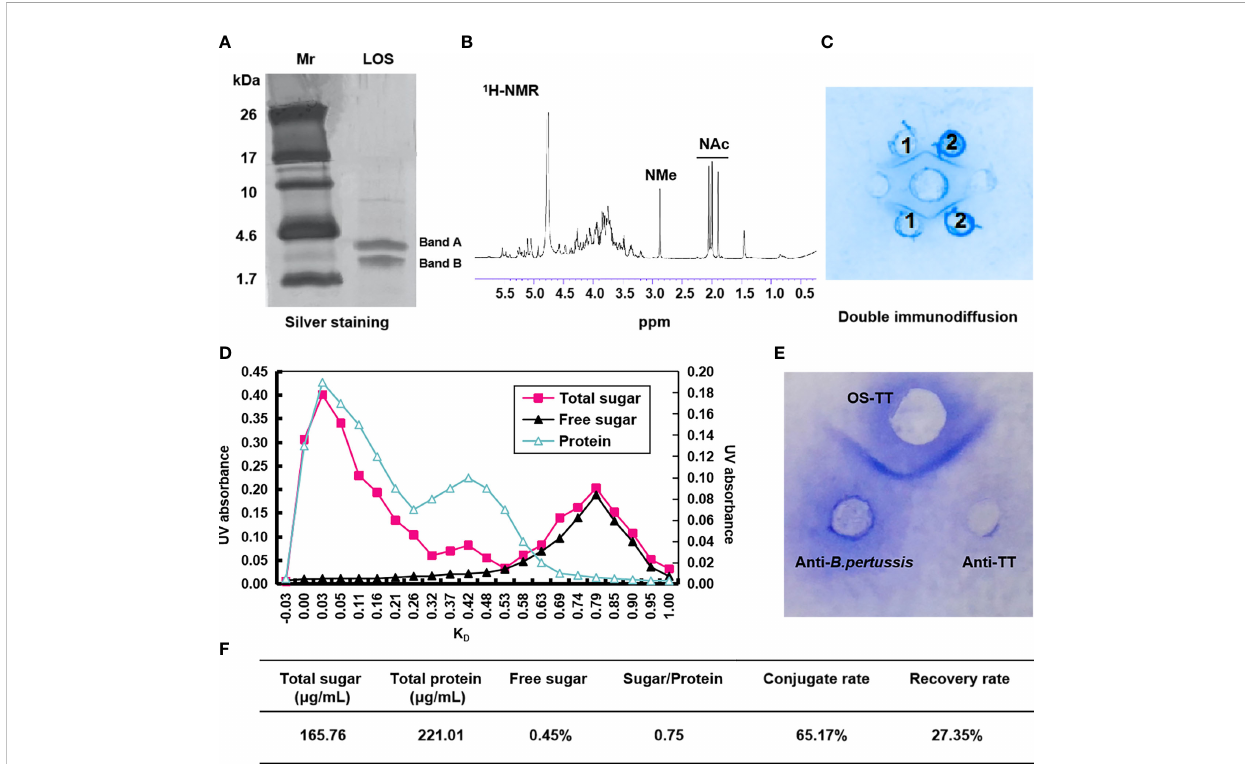
FIGURE 1 Characterization of B. pertussis lipooligosaccharides and conjugates. (A) Tricine-SDS − PAGE of B. pertussis LOS with silver staining. (B) 600 MHz 1 H NMR spectrum of OS. (C) Agarose double immunodiffusion assay of LOS and OS. Medium well: anti- B. pertussis serum; Well 1: LOS; Well 2: OS. (D) Chromatographic pro fi les of conjugate puri fi cation with Sephacryl S-300. (E) Agarose double immunodiffusion assay of the conjugate. (F) Primary characteristics of conjugates. Sugar/Protein: wt/wt ratio sugar to protein; Conjugate rate=(1-Polysaccharide content in supernatant×1.15/ Total polysaccharide content)×100%; Recovery rate=(Polysaccharide content in conjugate/polysaccharide content during conjugate reaction)×100%; Mr: Marker; ppm: Pages per minute; K D : partition coef fi